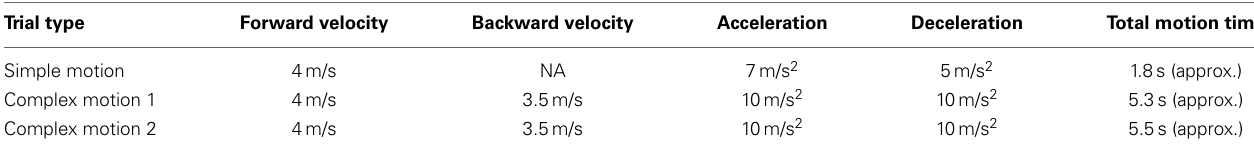
Table 1 | Motion parameters for each type of target motion a bat was presented with for the platform tracking